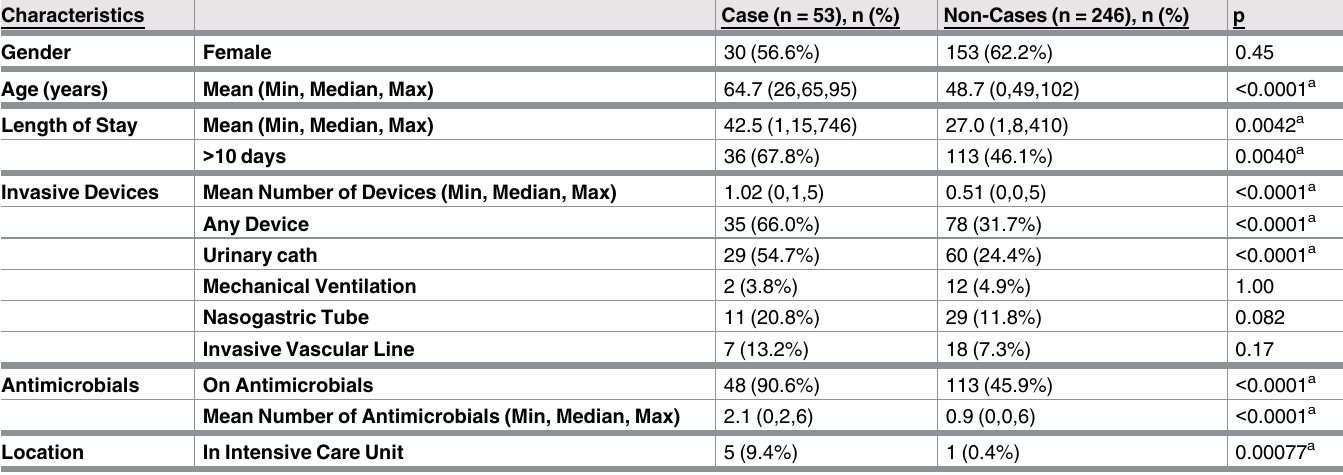
Table 1. Characteristics of CRKP positive patients from point prevalencestudy.